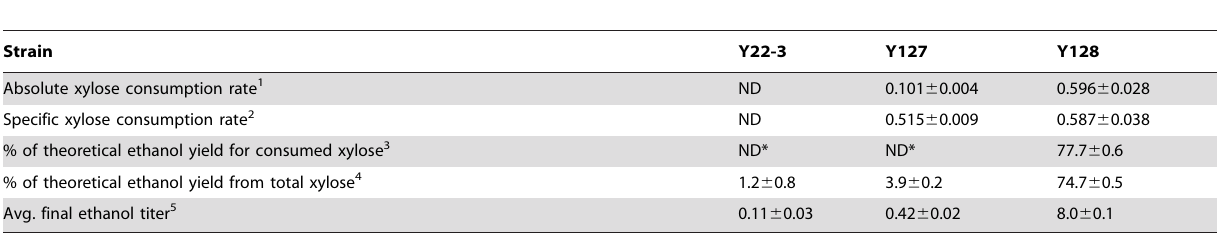
Table 3. Comparison of anaerobic fermentation kinetics for Y22-3, Y127 and Y128 in YPX medium.